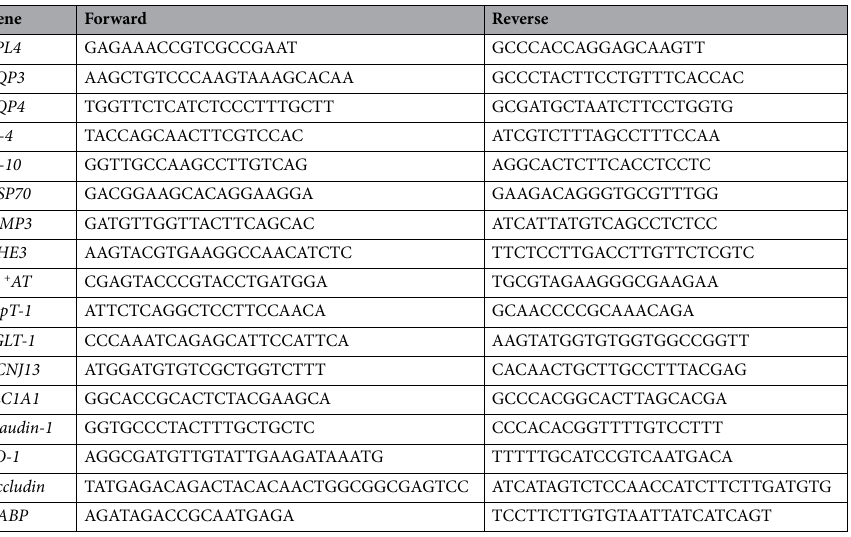
Table 2. Sequences of the primers used for quantitative real-time PCR analysis. RPL4: ribosomal protein L4; AQP3: aquaporin 3; AQP4: aquaporin 4; HSP70: heat shock protein 70; IL-4: interleukin 4; IL-10: interleukin 10; MMP3: matrix metallopeptidase 3; NHE3: sodium hydrogen exchanger 3; b 0, + AT: B(0, +)-type amino acid transporter; PepT-1: peptide transporter 1; SGLT-1: sodium/glucose cotransporter member 1; KCNJ13: potassium voltage-gated channel subfamily J member 13; SLC1A1: excitatory amino-acid transporter 3; ZO-1: tight junction protein 1; iFABP: intestinal fatty-acid binding